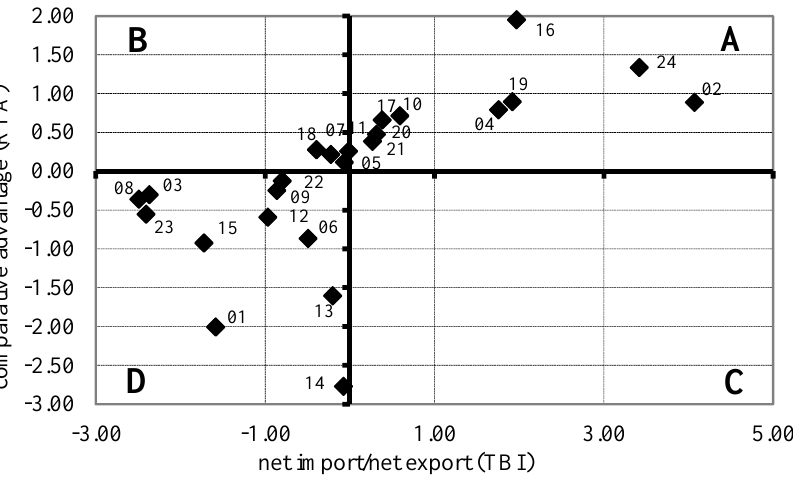
Figure 4. Positioning of agri-food products by the level of comparative advantages and export-import relations in 2017, by HS